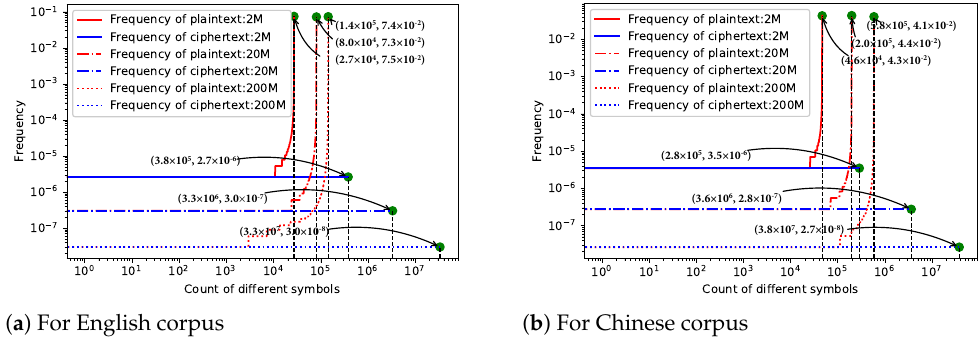
Figure 11. Frequency distribution of plaintext and